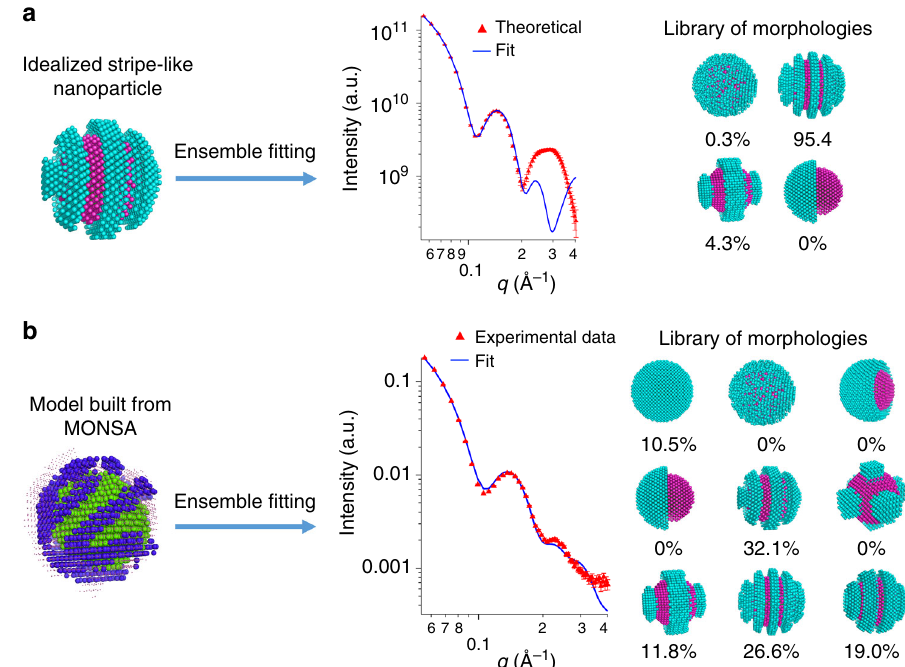
Fig. 4 Fitting of the SANS data with a library of morphologies. The SANS pattern of idealized stripe-like structure ( a ), and 5.5 nm dPET-DDT nanoparticles ( b ) are fi tted using the OLIGOMER package. The experimental data are represented by the red curve while the fi tting result is the blue curve. The contribution from each morphology in the library is listed. The χ 2 values for the fi ttings are 112.6 for the idealized stripe-like structure and 19.4 for dPET- DDT